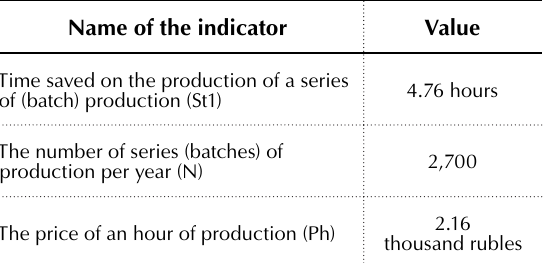
Table 3. Data for calculation of